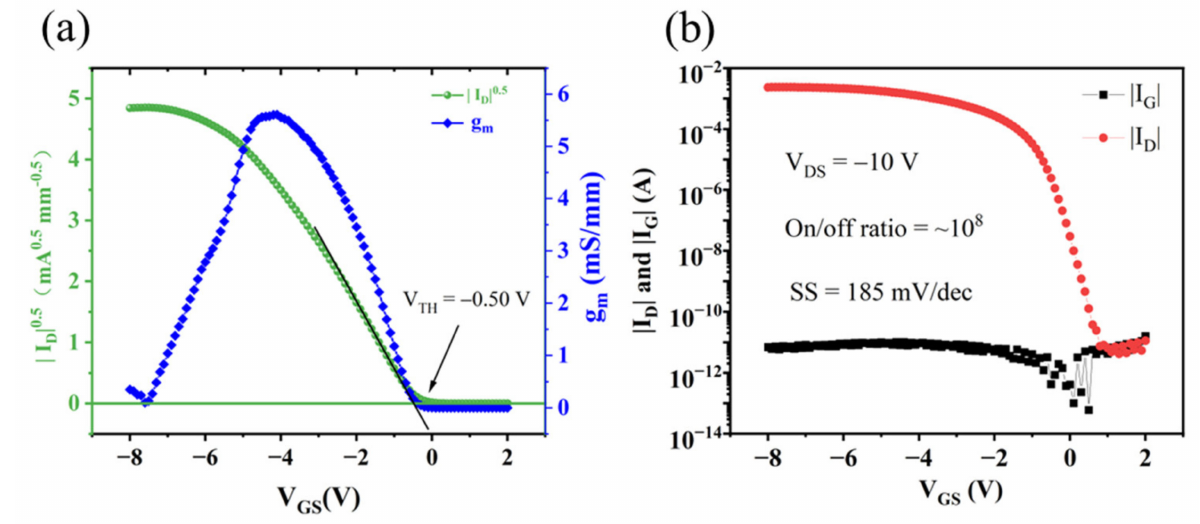
Figure 4. ( a ) transfer characteristics and transconductance of the SnO x /H-diamond based FET. ( b ) |I D | and |I G | in logarithmic